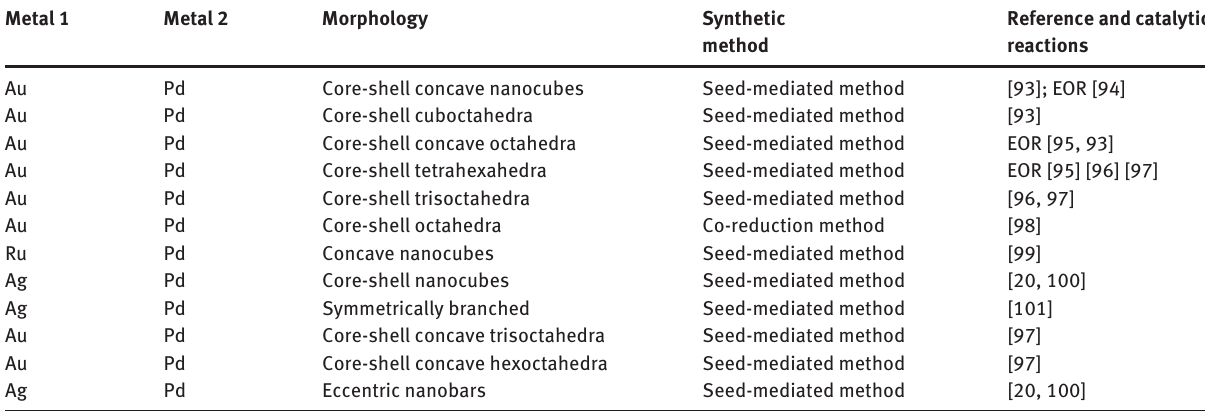
Table 5 List of polyhedral Pd-M bimetallic core-shell nanostructures, their synthetic methods, and catalytic reactions. Metal